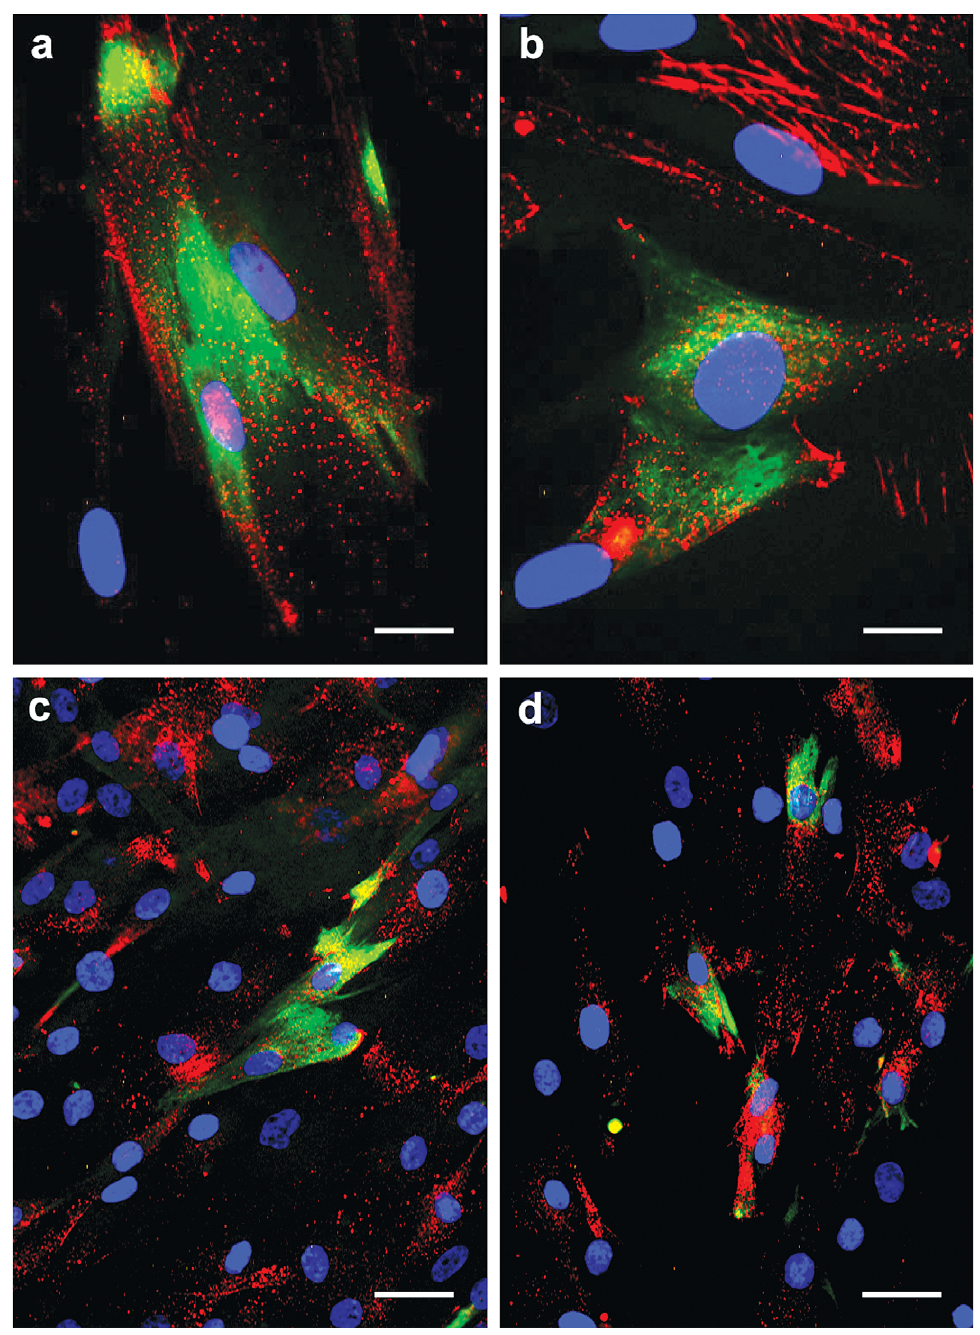
Fig. 3. Expression of CD133 and nestin in rhabdomyosarcoma cell lines. Representative double labeling for CD133 and nestin in NSTS-9 (a, b) and NSTS-8 (c, d) rhabdomyosarcoma cell lines. CD133 showed predominantly membranous positivity, visible as a dotted CD133 signal (red) on the cell surface (a-d). Invaginations of plasma membrane accumulating CD133 signals (red) led to the stripped pattern in a small subset of cells (b). CD133 (red) and nestin (green) stained by indirect immunofluorescence using TRITC-labeled secondary antibody and FITC-labeled secondary antibody, respectively; counterstaining with DAPI. Bars, 25 (cid:1) m (a, b), 50 (cid:1) m (c,